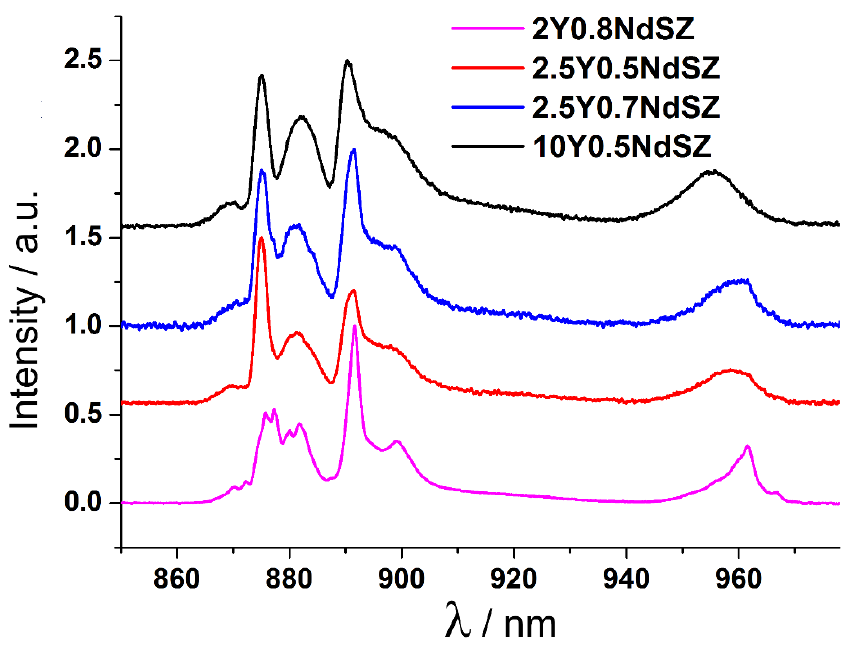
Figure 2. Luminescence spectra of Nd 3+ ions for the 4 F 3/2 → 4 I 9/2 transition 4 F 5/2 level excitation for YNdSZ single crystals for 4 F 5/2 level excitation with a 800 nm semiconductor laser at T = 77 K.